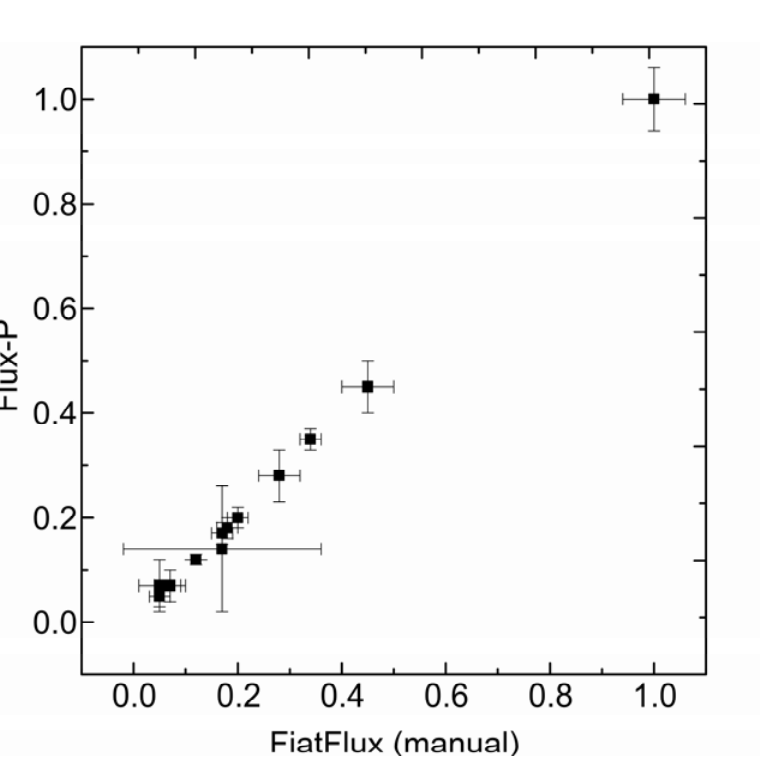
Figure 6. Consistency of metabolic flux ratio analysis calculated with Flux-P. H. polymorpha metabolic flux ratios (unpublished data) calculated manually with FiatFlux and with Flux-P show high